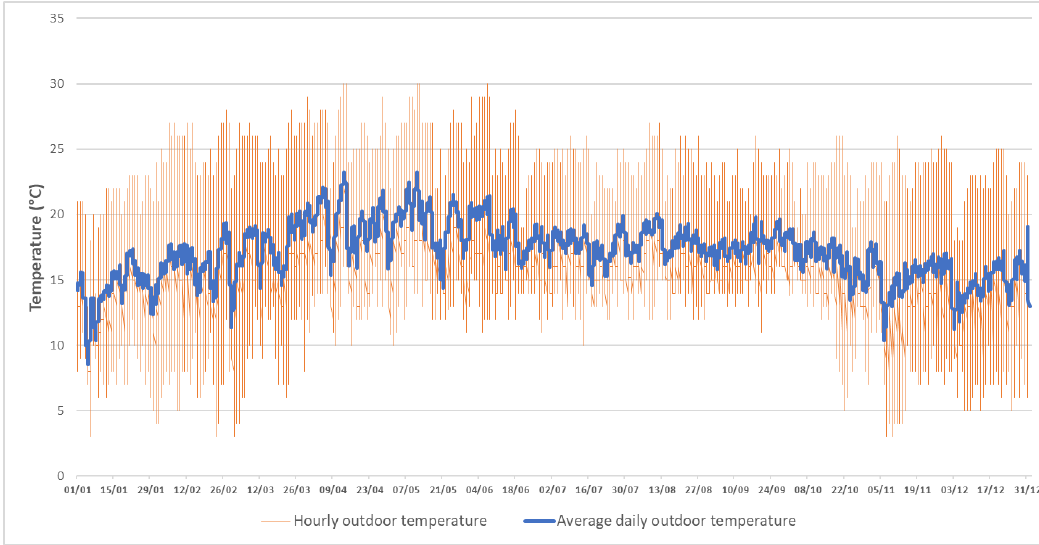
Figure 3. Hourly outdoor air temperature and average outdoor temperature of the typical meteorological year (TMY) of Mexico City based on its EnergyPlus weather (EPW) files.